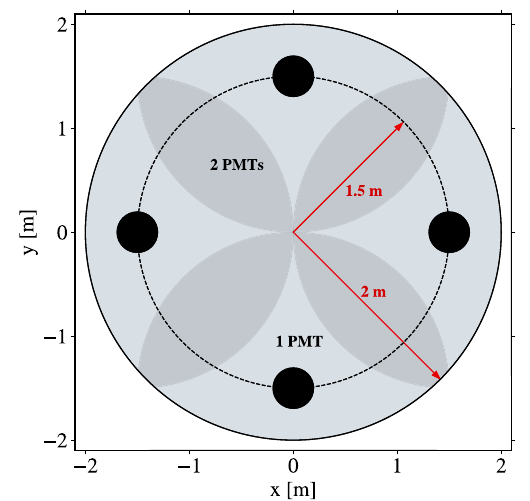
Fig. 1 Single-layered WCD design. A dark circular area with a radius of 1.5 m was drawn around each 8-inch PMT (represented as black cir- cles). Taking into account the height of this WCD, the direct Cherenkov lightof averticalmuon thatcrosses theWCDthrough one ofthese areas should be detected by its correspondent PMT (it could be detected by two PMTs in the case that a muon crosses the station through the inter- section of two dark